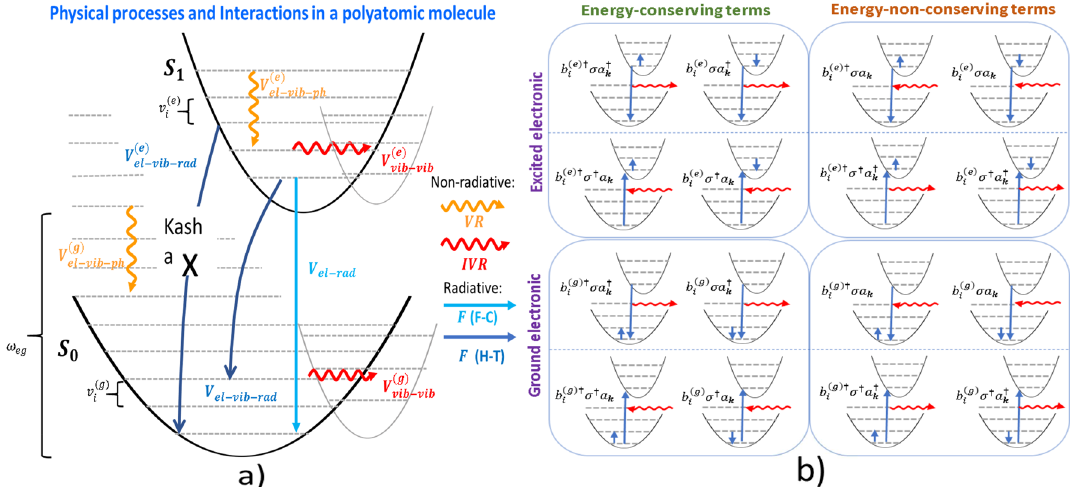
Figure 1. ( a ) Open quantum system model of an impurity molecule in phonon and radiation baths. The system (molecule) contains two electronic states, the ground singlet state S 0 and excited singlet state S 1 with energy ( g ) v ( e ) gap ω eg = ω e − ω g and localized vibrational modes with frequency v i ) for the ground (excited) state. i ( The localized vibrational modes of the molecule are described by a set of harmonic oscillators. The vibrational ( g ) ˜ v ( e ) frequencies are shifted to ˜ v i ) as a consequence of coupling to the phonon bath and internal coupling i ( within the system. The VR process from interactions with phonon bath manifest the Kasha rule which states that the vibrational relaxation in the excited state is typically very fast such that fluorescence only occur from the ground vibrational levels of the excited state. ( b ) A schematic diagram of different interactions that can take place in the Herzberg–Teller interaction term. The left panels are energy-preserving terms and the right panels are energy non-preserving terms usually neglected under RWA. The processes in the excited and ground electronic states are